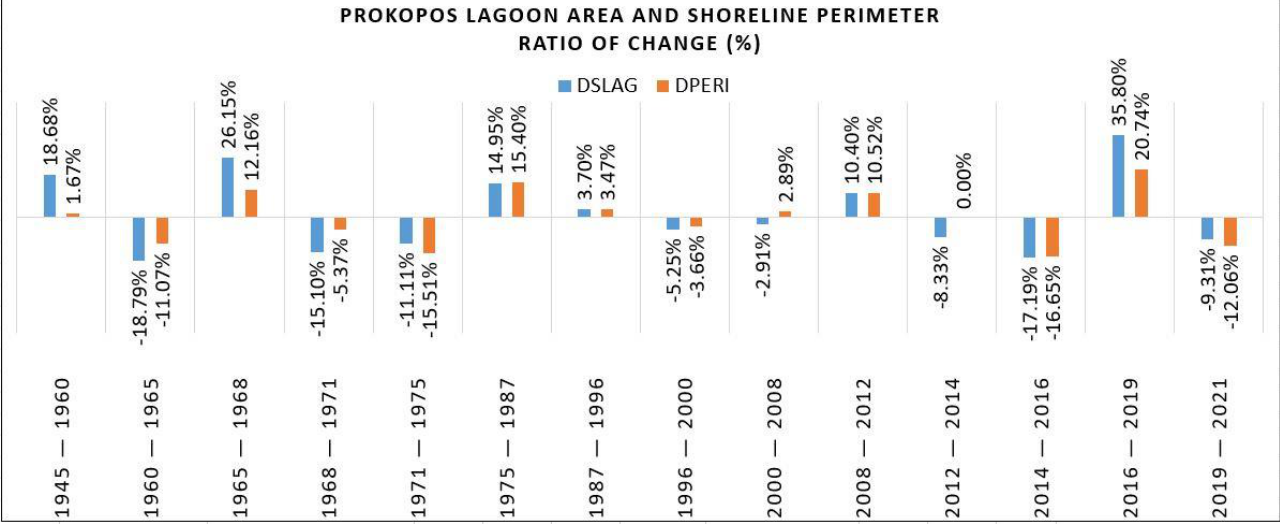
Figure 10. Ratio of change in lagoon area and perimeter during the study period. The maximum diameter of the lagoon ranges from 3.25 km (min) to 4.54 km (max), while the mean rate is 3.56 km. The respective rates corresponding to the minimum diam- eter of the lagoon are 1.98, 2.24 and 2.03 km, respectively. Finally, the rates of the perpen- dicular distance to the open sea coastline (DPER) range from 1.65 km (min) to 1.77 km (max), while the mean rate is 1.71 km. The respective rates of the parallel distance to the open sea coastline (DPAR) range from 2.82 km (min) to 4.05 km (max), while the mean rate is 3.25 km.